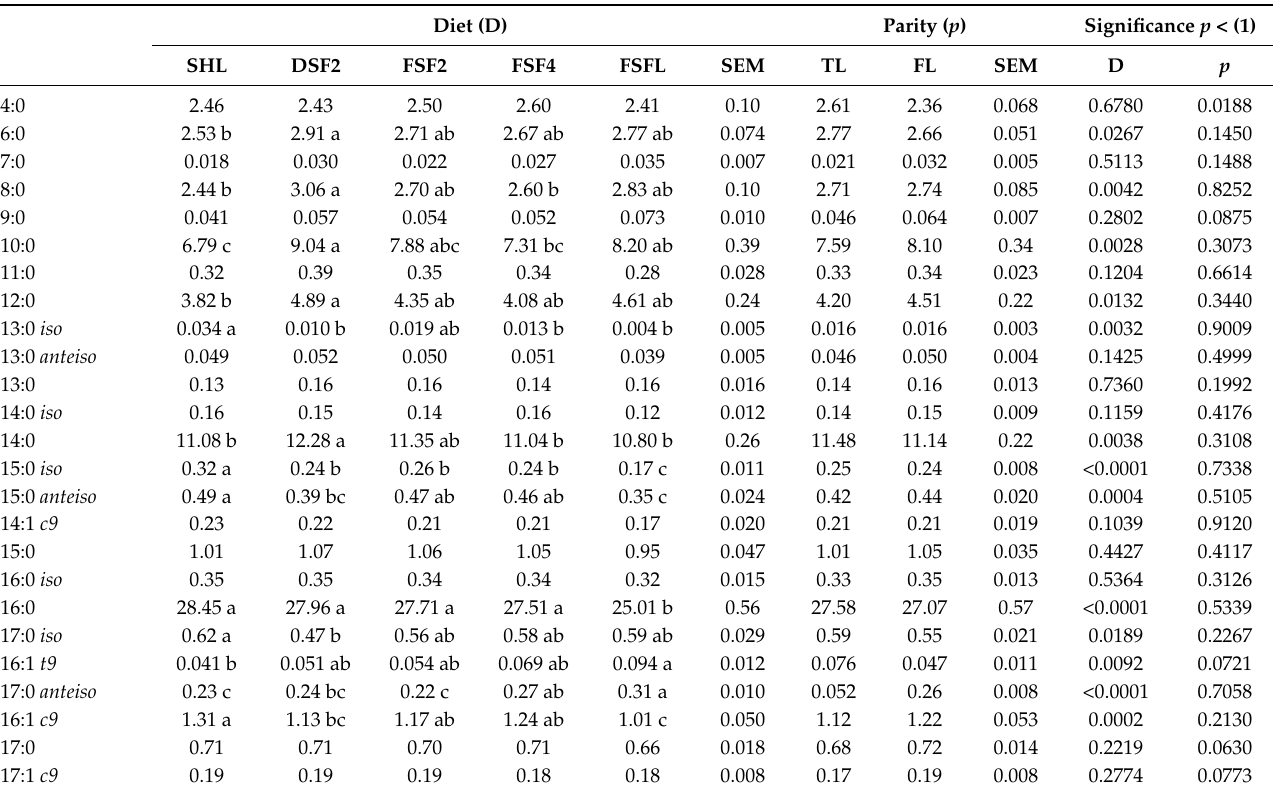
Table 3. The effect of diet and parity on fatty acid (FA) composition (g/100 g FA) of cheese fat: short and medium chain FA.